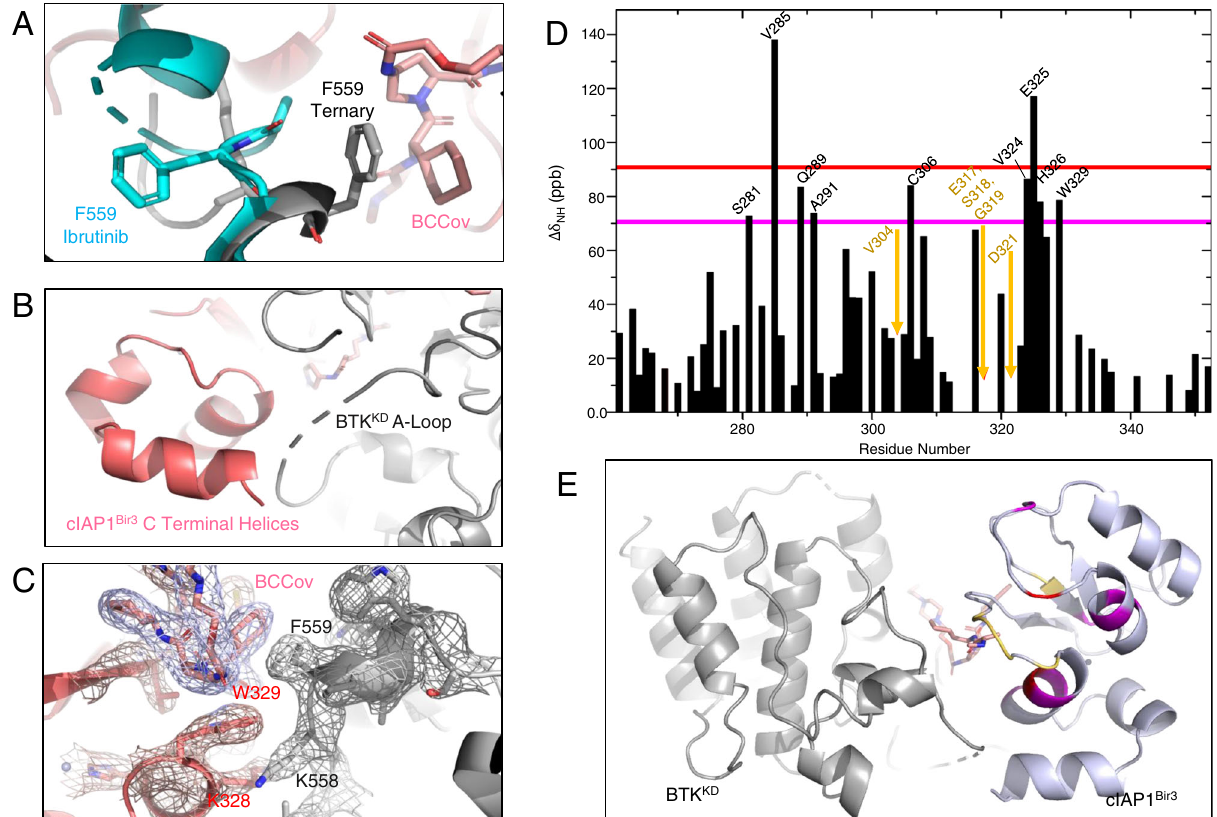
Fig. 5 | Detailed ternary complex interactions. A Hydrophobic interaction between BTK residue F559 (gray) and the cyclohexyl moiety (elemental/pink) on thecIAP1warhead,andtheconformationalchangeitundergoesascomparedtothe deposited structure of a BTK KD -ibrutinib complex (blue, RCSB 5P9J). B C-Terminal helices of cIAP1 Bir3 clash with the unstructured A loop of BTK KD . C Close lipophilic interactions at the ternary complex interface. Electron density mesh resolved at σ =1.0. D ChemicalshiftvariationsofcIAP1 Bir3 – BCCovuponbindingofBTK KD . Δδ